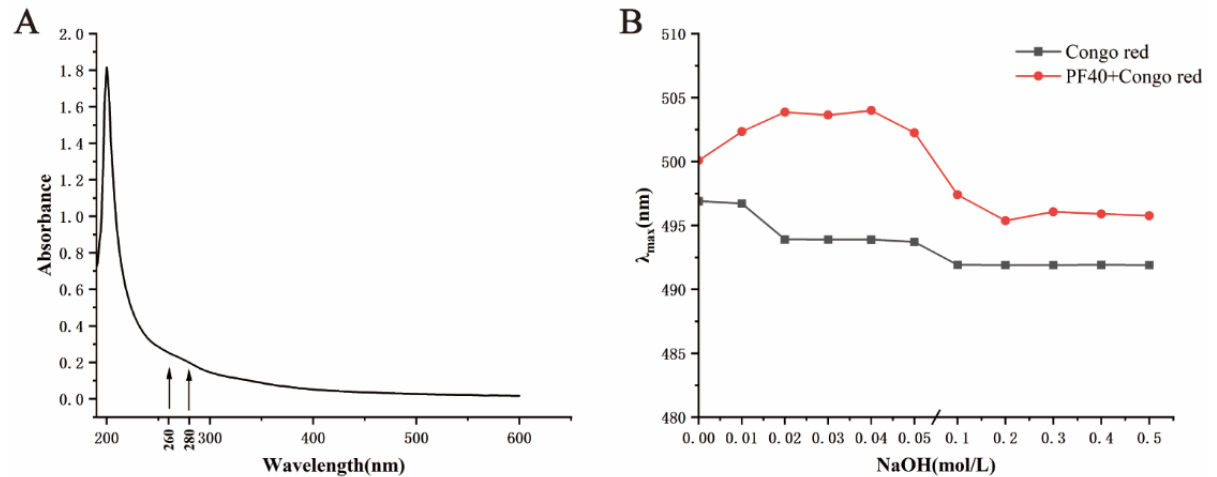
Figure 4. ( A ) UV spectrum and ( B ) Congo red test results of PF40.